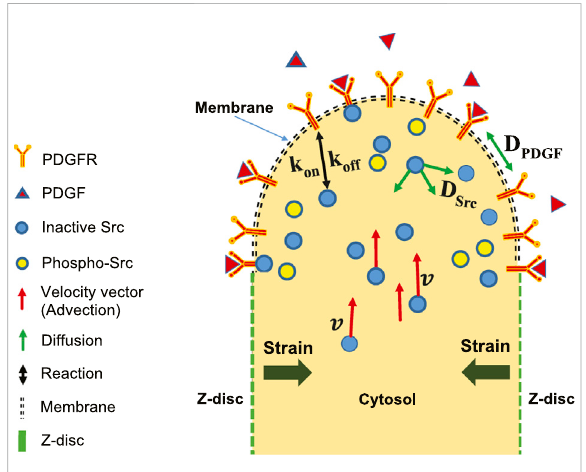
FIGURE 3 Schematic of reaction-diffusion-advection model in the upper half of two-dimensional longitudinal section of one SD. Shortening of SD causes strain. Extracellular PDGF can bind to membrane receptors, PDGFR. The intracellular inactive form of Src can bind to PDGFR. The inactive and activated forms of Src are free to diffuse in any direction, whereas PDGFR is limited to diffuse along the membrane plane, with the diffusion coef fi cients of D Src and D PDGFR respectively. The concentration of inactive and activated Src vary due to diffusion and reaction, but also vary due to advection (shown by velocity vector fi eld v). Advection is a consequence of strain, which is due to SD